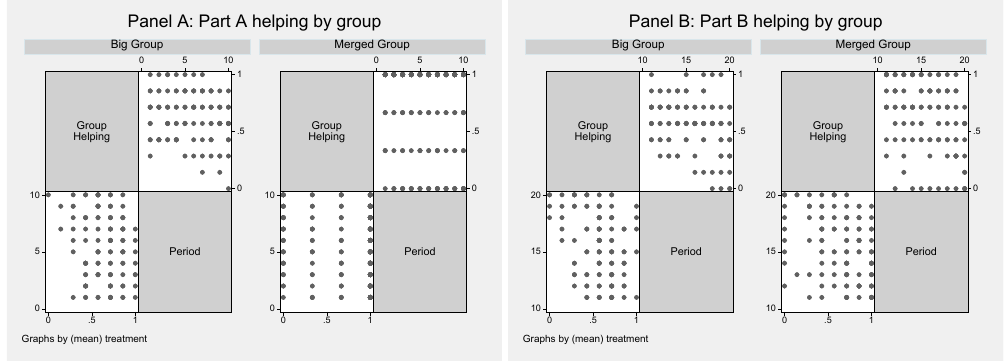
Panel B: Part B helping by group